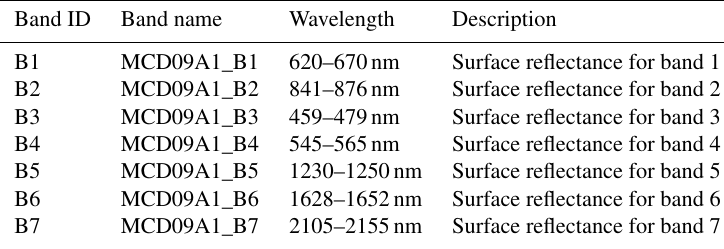
Table 6. Description of the seven spectral bands of MODIS